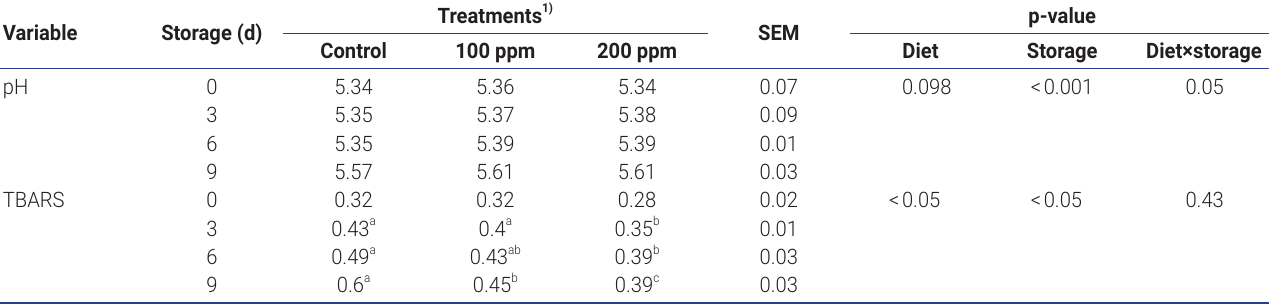
Table 5. Effect rumen protected γ-aminobutyric acid supplementation on pH and 2-thiobarbituric acid reactive substances level (mg malondialde - hyde/kg meat) of longissimus lumborum from Hanwoo steers during refrigerated storage